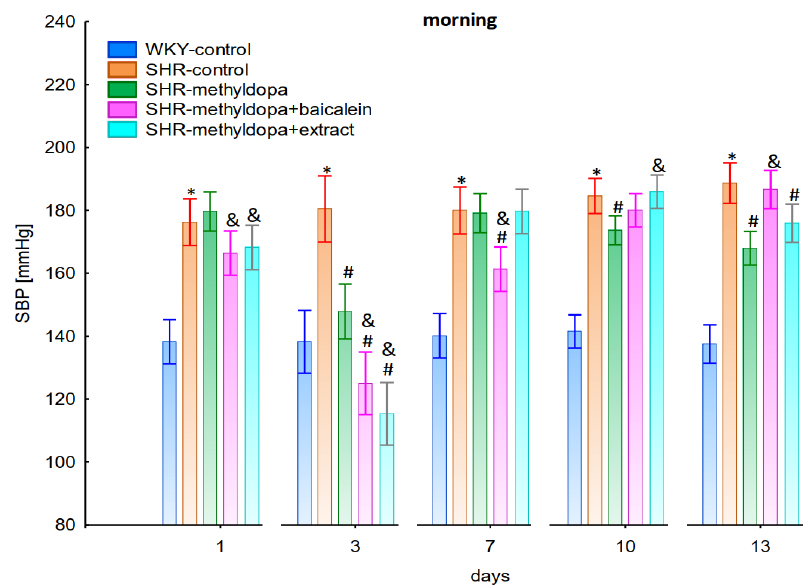
Figure 1. Influence of methyldopa and its combination with baicalein or extract from Scutellaria baicalensis roots on morning systolic blood pressure (SBP) in SHR pregnant rats. Legend: n = 10, mean ± SEM; * — vs. WKY control, p < 0.05; # — vs. SHR control, p < 0.05; & — vs. SHR-methyldopa, p < 0.05.